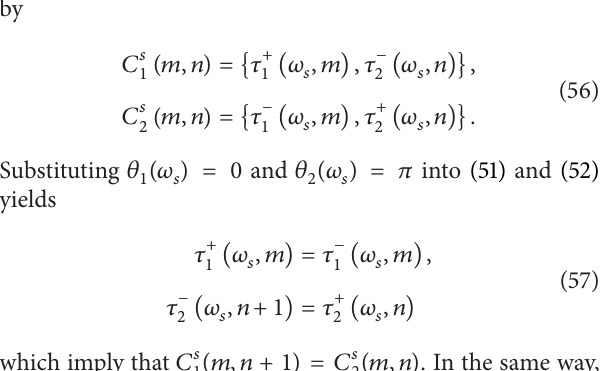
lowest red and blue segments are 𝐶 1 ( 1 , 1 ) and 𝐶 2 ( 1 , 1 )